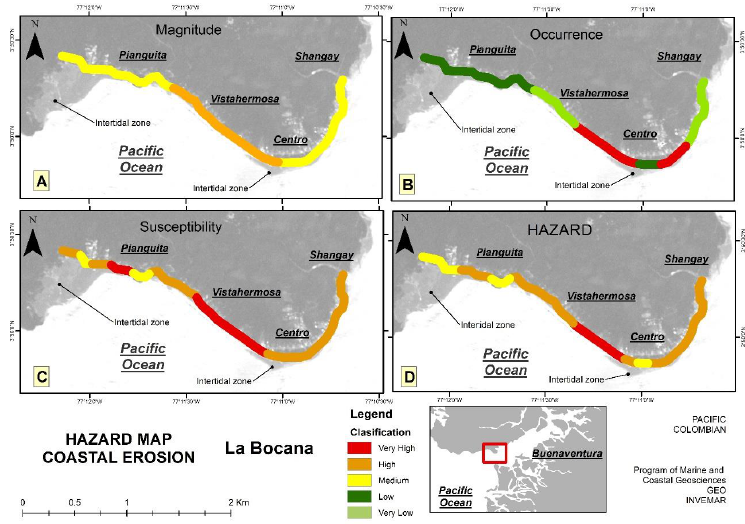
Figure 5. Hazard of coastal erosion in La Bocana, Pacific Coast. ( A ) Magnitude, ( B ) Occurrence, ( C ) Susceptibility, and ( D ) Hazard.